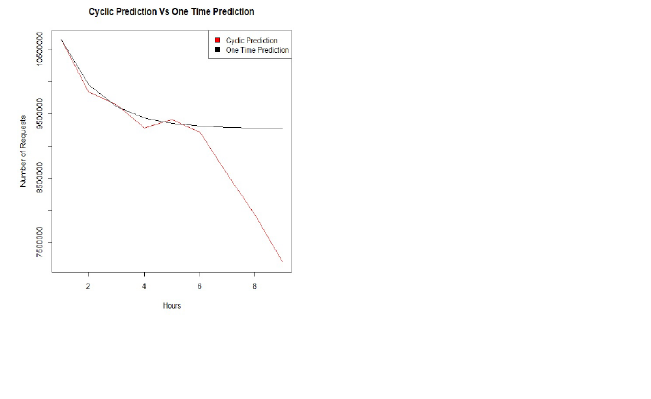
Figure 4. OneTime VS Cyclic